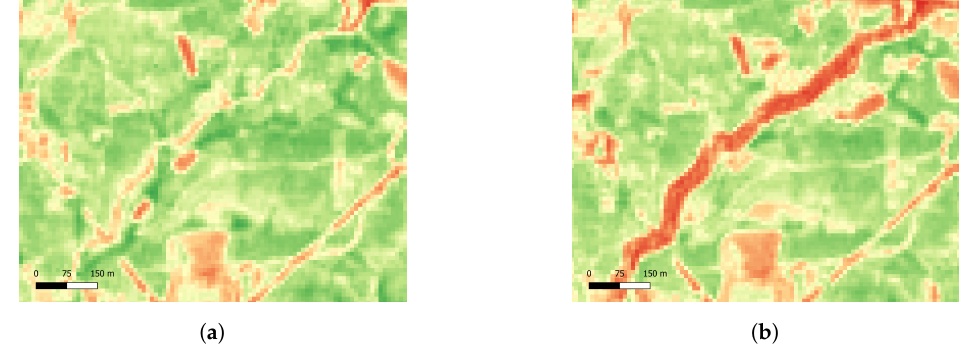
Figure 16. NDVI before and after the intervention for Site B. ( a ) NDVI on 15 May 2018. ( b ) NDVI on 19 June 2018.